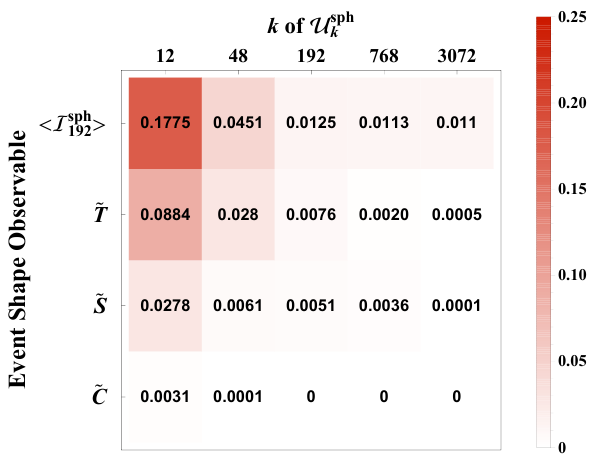
Figure 3 . Event shapes evaluated on the HEALPix quasi-isotropic con(cid:12)gurations with k = f 12 ; 48 ; 192 ; 768 ; 3072 g . We show the rescaled observables from table 2 such that a value near zero indicates a quasi-isotropic event. Observables with darker shading indicate more dynamic range. We average the value of event isotropy over 10 3 random orientations. While thrust has a larger dynamic range than sphericity, note that it counterintuitively ranks a ring plus back-to-back particle con(cid:12)guration ((cid:12)gure 4(a), T = 0 : 074) as slightly more isotropic than an k = 12 sphere tiling ( T = 0 : 088). For additional values I sph beyond n = 192, see (cid:12)gure 12. n